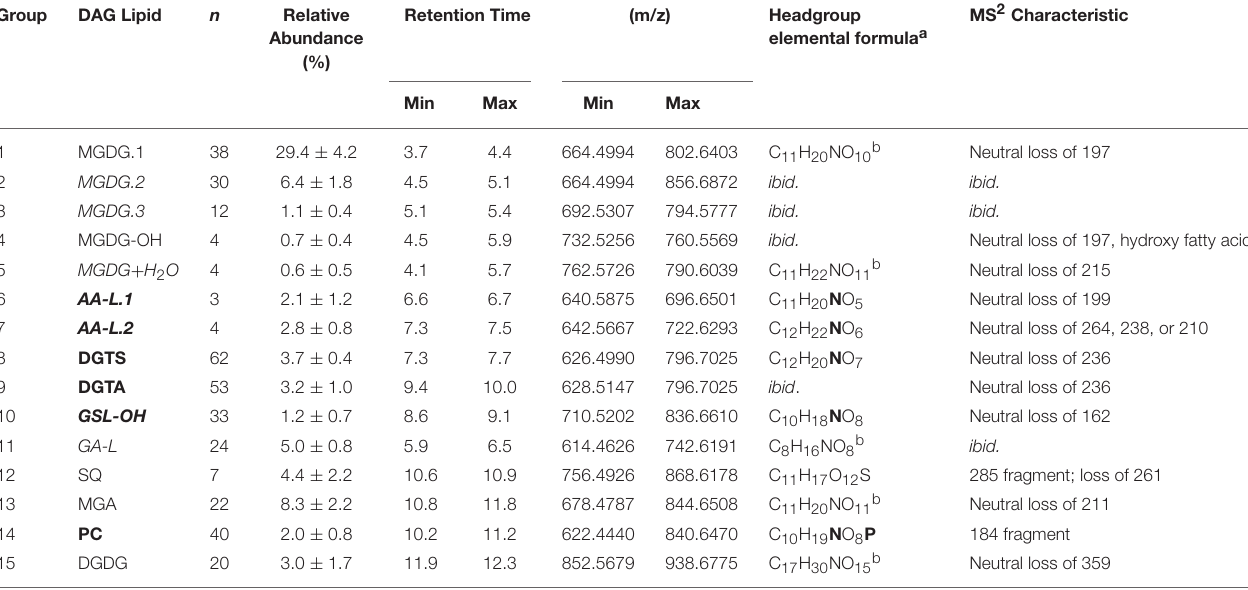
Neutral loss of